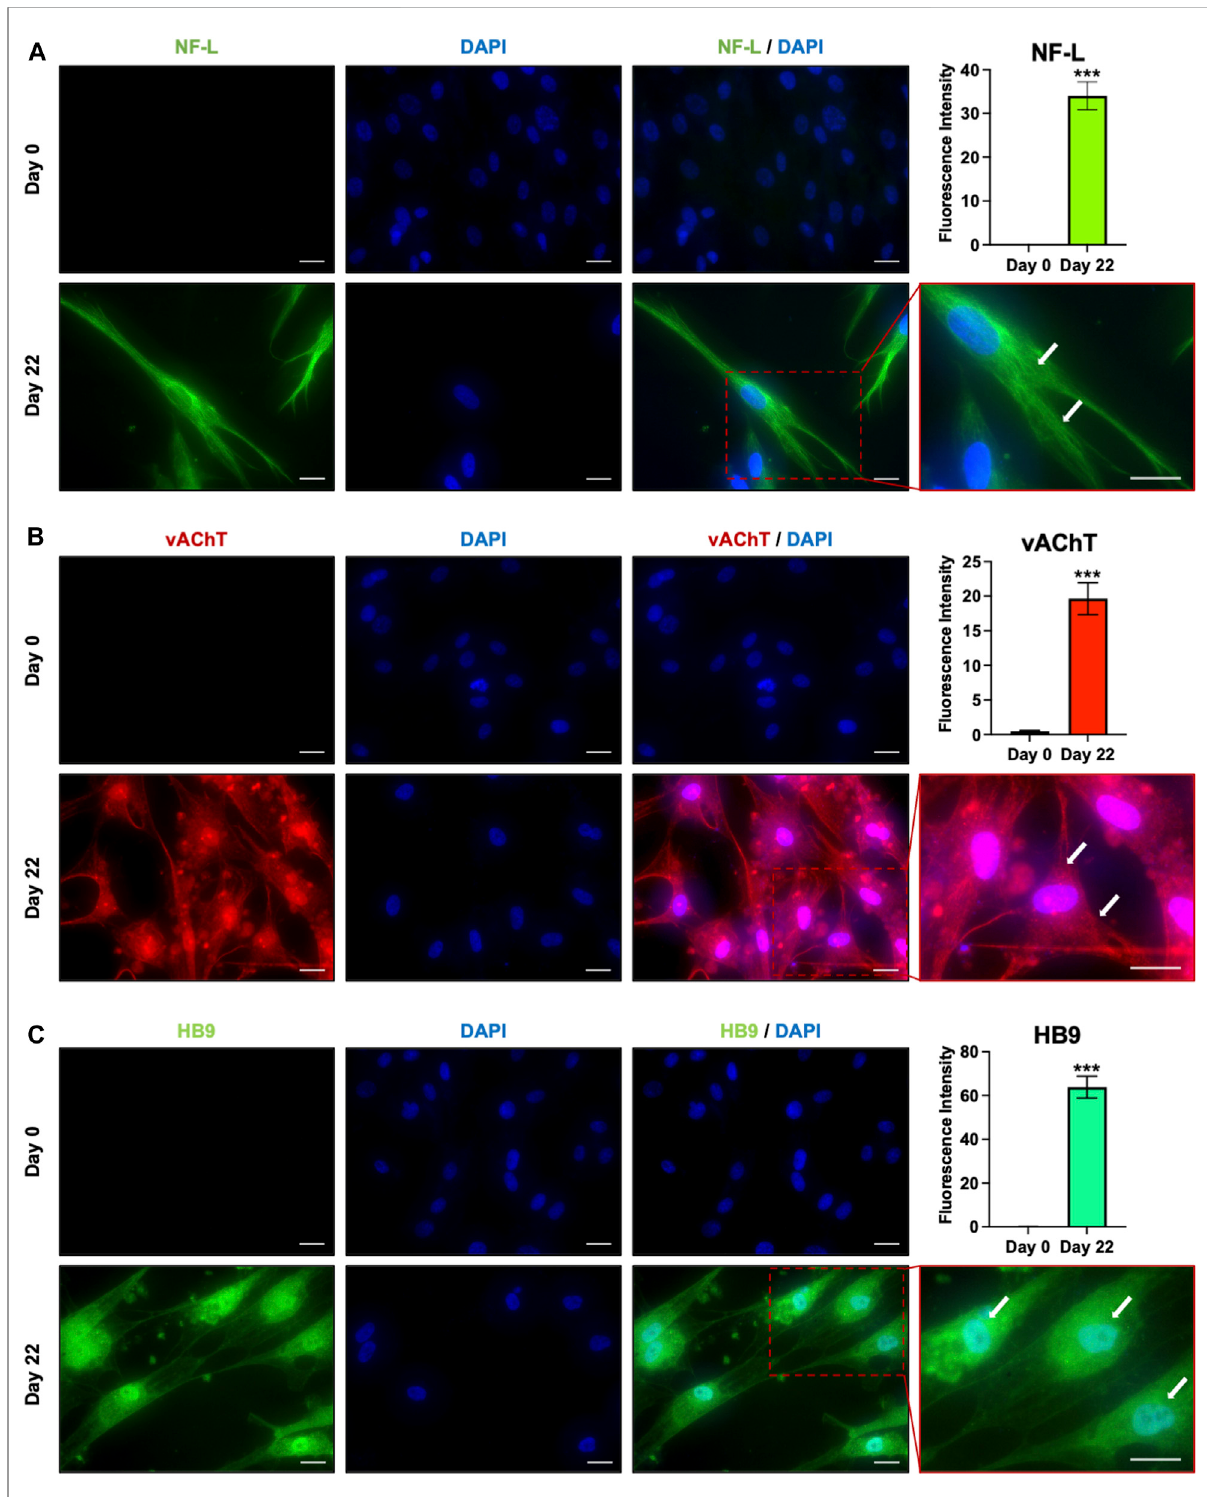
FIGURE 4 Functional features of hAFSC-derived MNs. (A) Calcium imaging in hAFSC-derived MNs after 22 days of differentiation. Cells were stimulated with 50 mM of KCl. F/F0 represents the ratio of fl uorescence intensity for each cell at the indicated time. (B) NMJ detection in the co-culture of hAFSC-derived MNs and myotubes. MNs were labelled with a blue vital staining, whereas the AChRs on myotubes were stained with the α -BTX (green). Red rectangle represents enlarged area (60x). White arrow indicates neuronal terminals ending on the α -BTX (AChRs). Magni fi cation